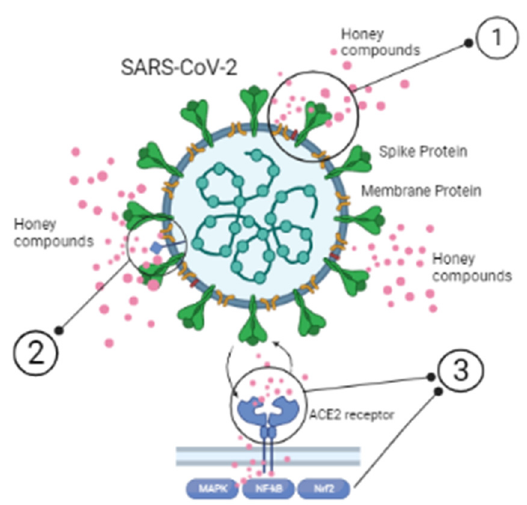
Figure 3. Possible mechanisms responsible for honey bioactivity against SARS-CoV-2: (1) altering the viral structure: interaction of honey and its major components with structural and/or non-structural proteins in the virus; (2) binding to target receptors on the virus; (3) interrupting membrane proteins (crucial for the viral attachment and entry into the host cells). Illustrations were made with BioRender.